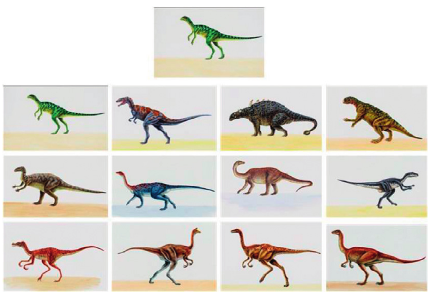
Figure 12: Retrieval of top 12 images as a result of search image selected from dinosaur category.